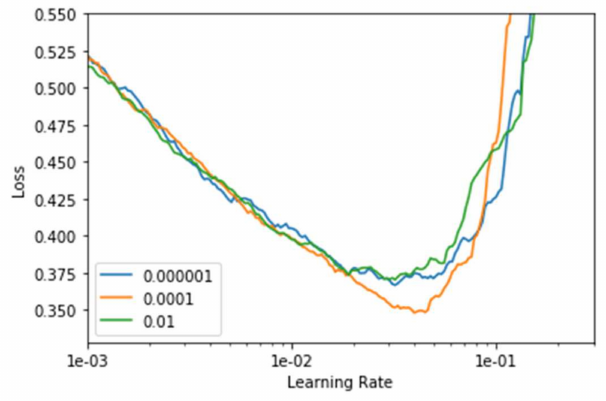
Figure 6. Graph representing the learning rate associated with weight decay.